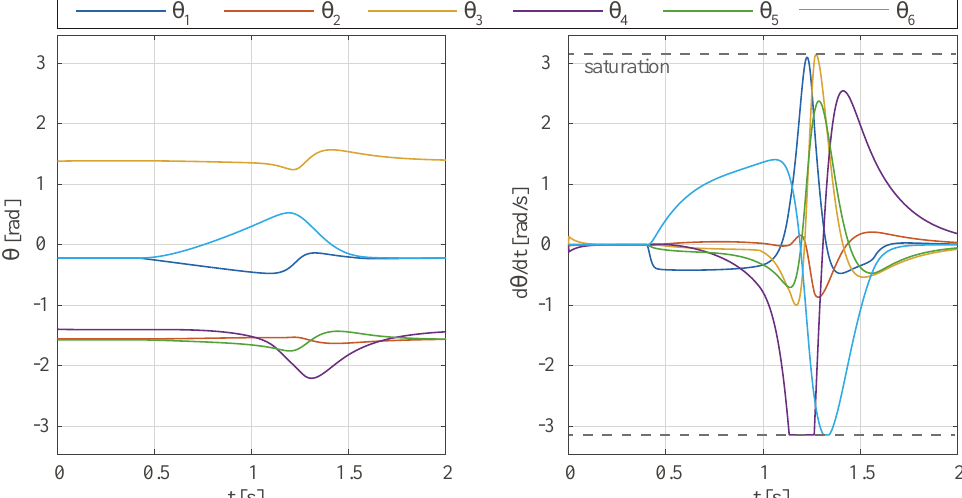
Figure 7. Avoidance of a moving obstacle interfering with the end-effector in a fixed position— mode III.